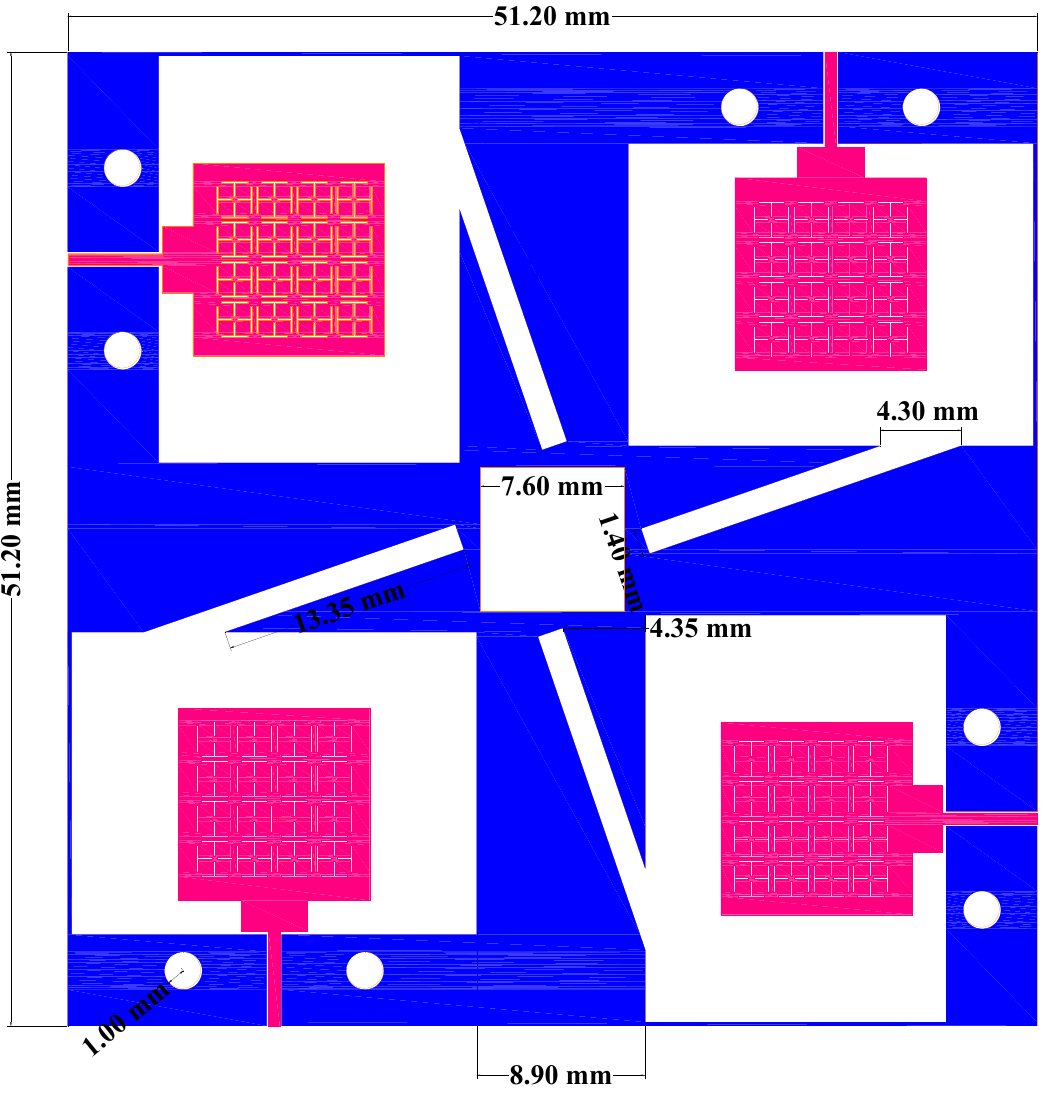
Figure 8. Structure of a four-cell MIMO antenna with polarization diversity.